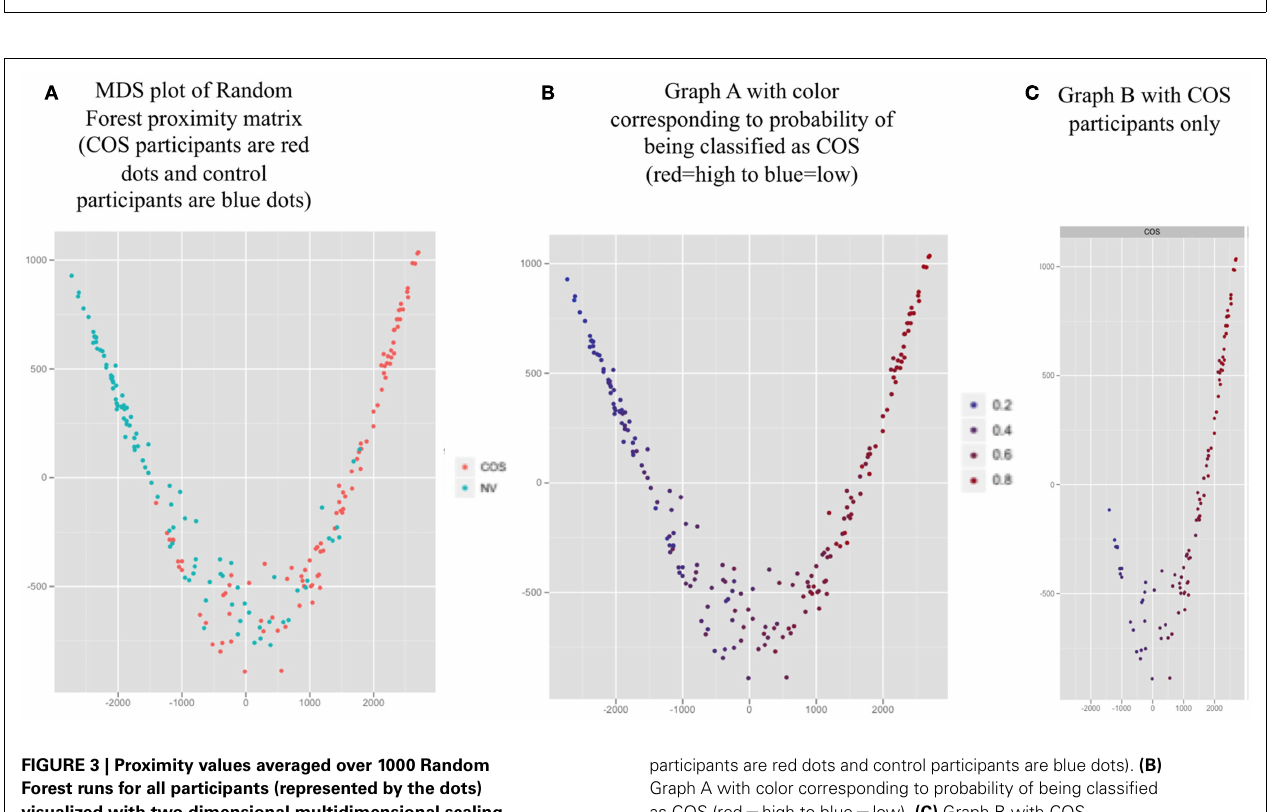
FIGURE 3 | Proximity values averaged over 1000 Random Forest runs for all participants (represented by the dots) visualized with two dimensional multidimensional scaling (MDS). (A) MDS plot of Random Forest proximity matrix (COS